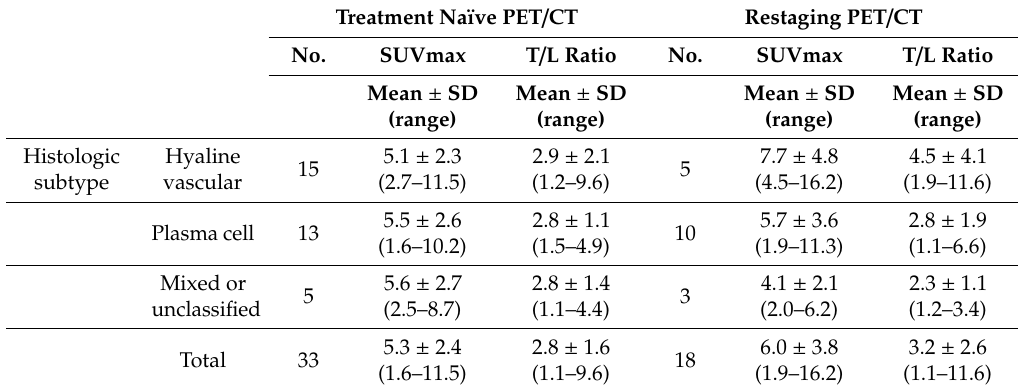
Table 4. Standardized uptake value (SUV) measurements of the involved LNs.